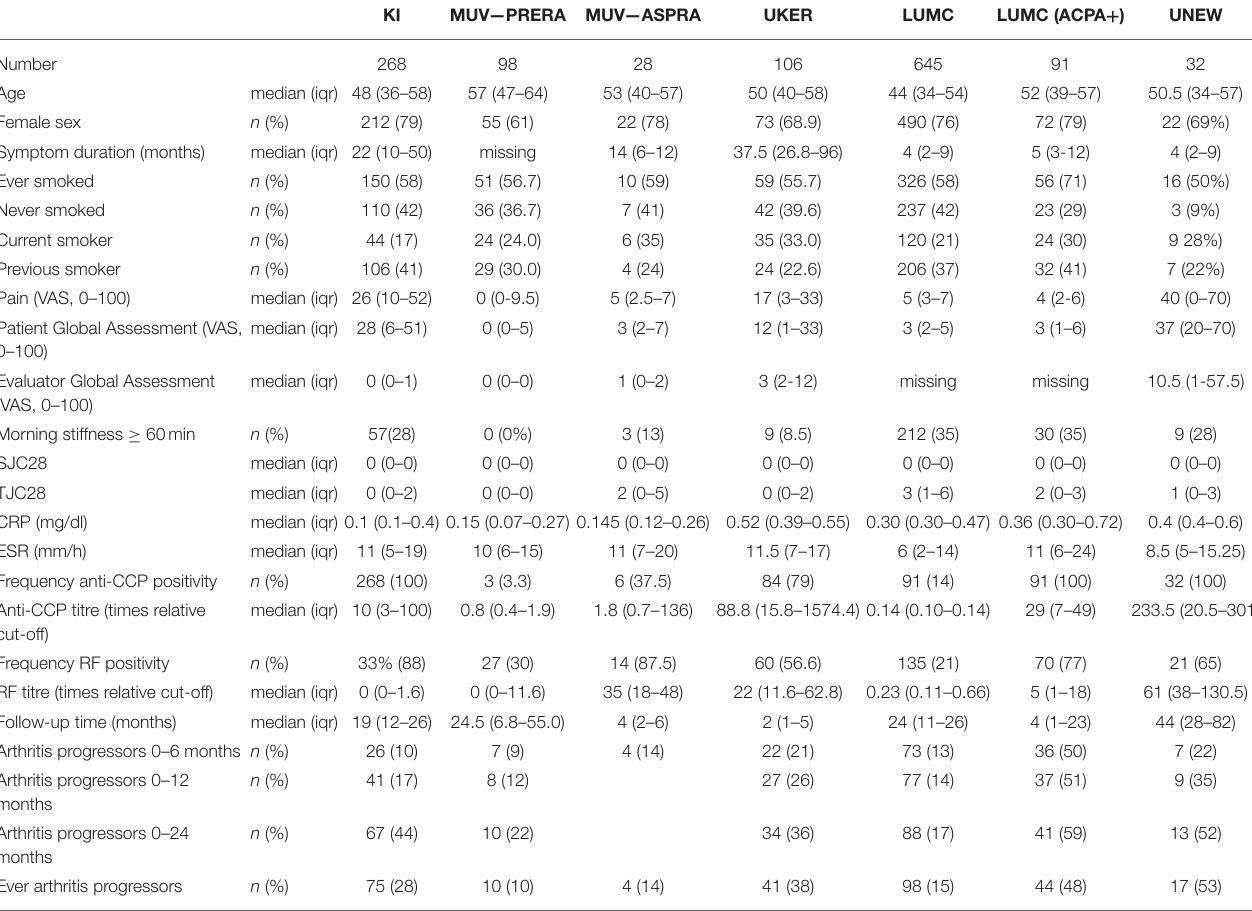
TABLE 3 | Overview of risk cohorts included in the RTCure at-risk registry infrastructure, with follow-up data in July 2021. KI MUV—PRERA